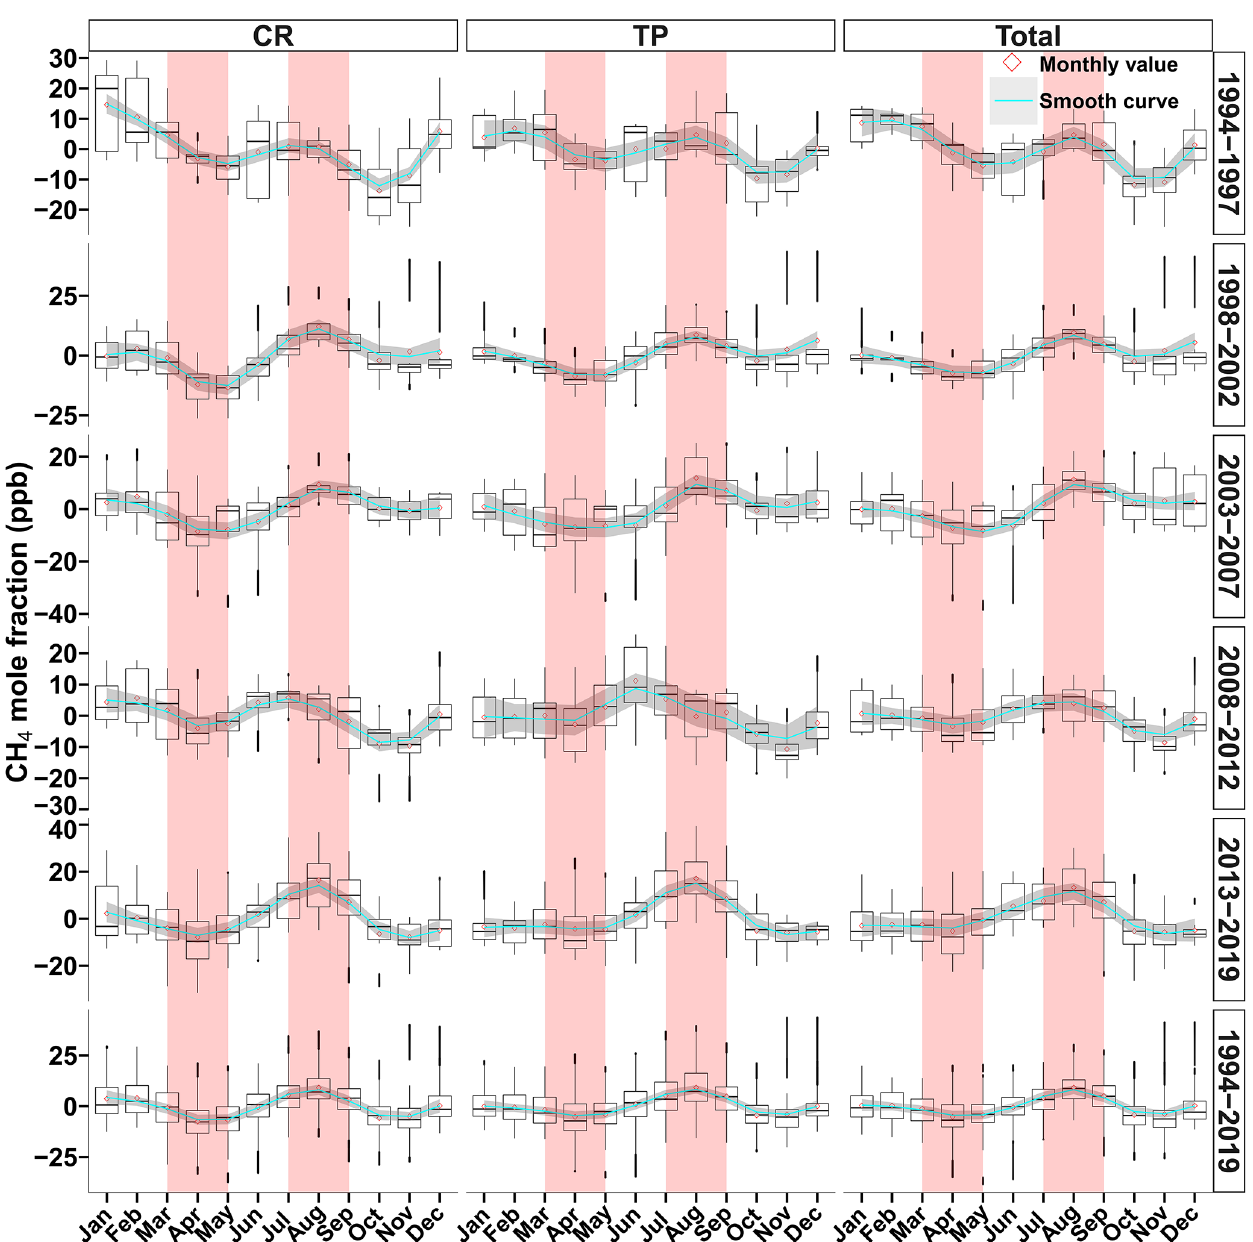
Figure 10. Monthly variations in regional CH 4 mole fractions from 1994 to 2019 at WLG station. CR, TP, and total represent the measure- ments from the city region, the Tibetan Plateau, and the total regional records, respectively. The box shows the 25th percentile, the median, and the 75th percentile from bottom to top. The bottom and the top whiskers, respectively, reach the minimum and 1.5 times the interquartile range (IQR). The black points are identified as outliers. The red squares are the averages. The cyan lines are the smoothed curve of the averages using the method of local polynomial regression fitting (loess). The gray bands are the 95% confidence interval of smoothed